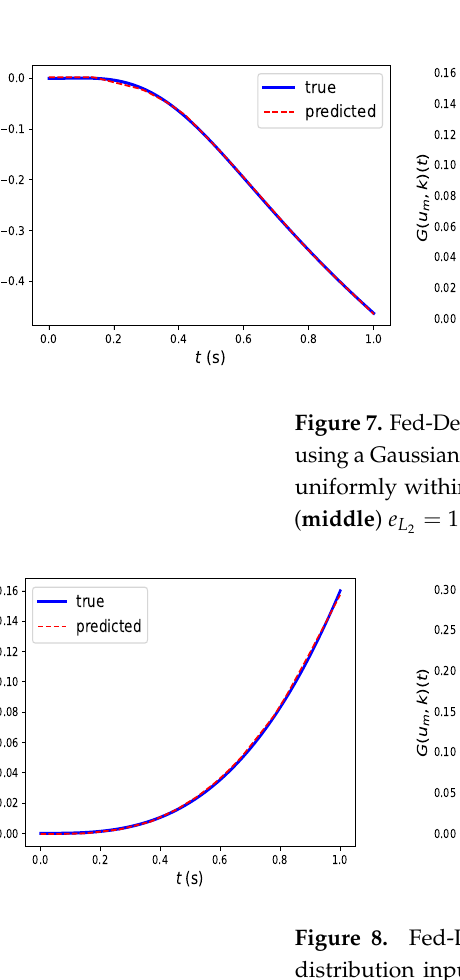
Figure 8. Fed-DeepONet G θ ∗ prediction of three solution trajectories driven by three out-of- distribution inputs: ( left ) u ( t ) = t , ( middle ) u ( t ) = sin ( π t ) , and ( right ) u ( t ) = t sin ( 2 π t ) and parameter k sampled uniformly within the interval [ 0.5,1.5 ] . The computed L 2 -relative errors are: = 1.726%, ( middle ) e = 0.419%, and ( right ) e = ( left ) e L L 2 L 2 2